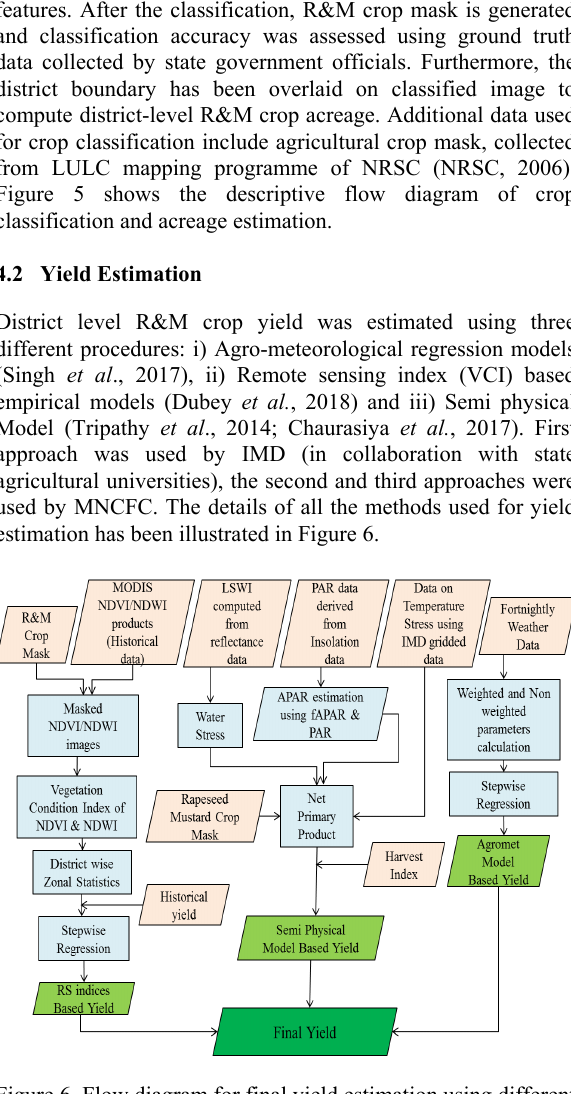
Figure 6. Flow diagram for final yield estimation using different